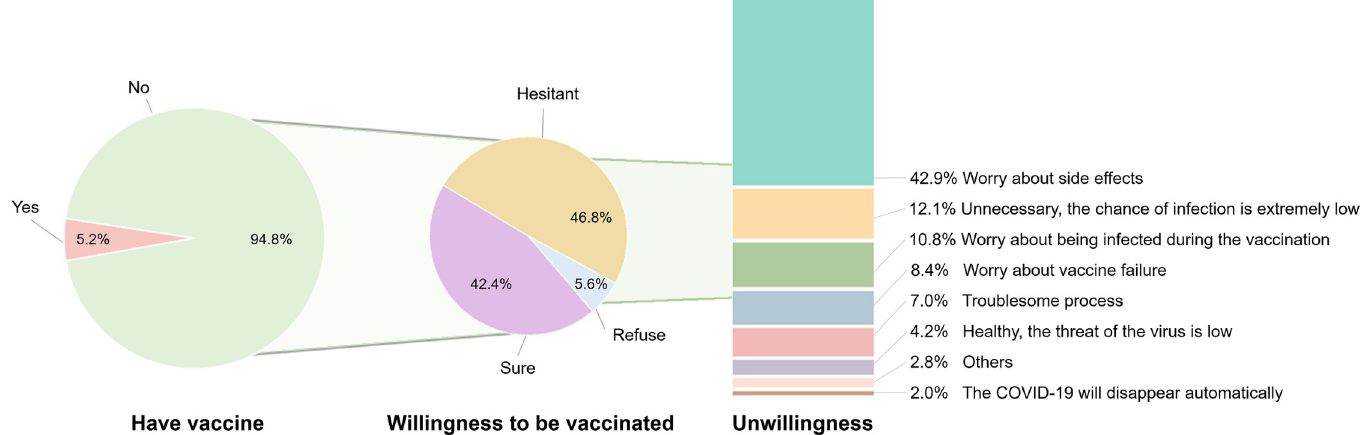
Fig 5. The proportion of respondents who were vaccinated in Stage 4 and the willingness of those who were not vaccinated to vaccinate as well as the reasons for reluctance to vaccinate.